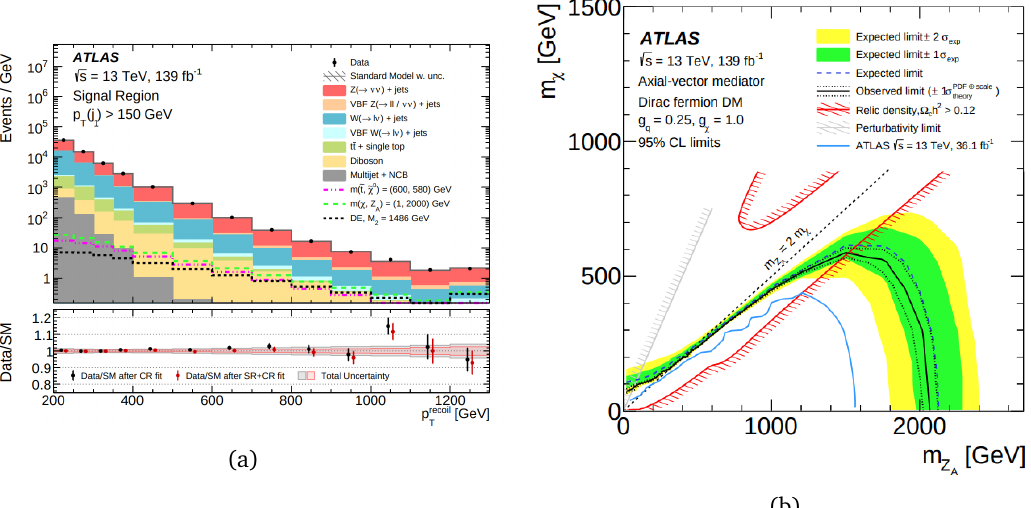
Figure 1: (a) Measured distributions of p recoil the SR. (b) 95% CL exclusion contours in the m axial-vector mediator model [ 5 ] .